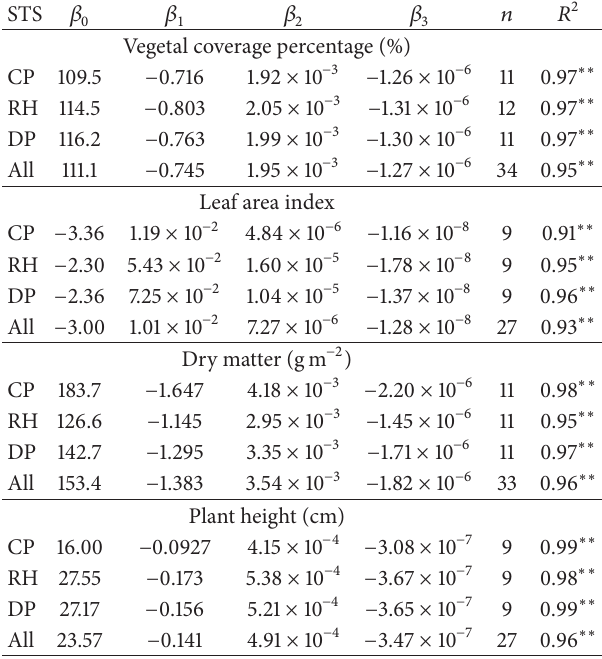
Table3:Polynomialequations( 𝑌 = 𝛽 0 +𝛽 1 𝑋+𝛽 2 𝑋 2 +𝛽 3 𝑋 3 )relating the bean crop growth parameters to thermal time (degree-days accumulated), for each soil tillage system (STS): chisel ploughing (CP),diskploughing(DP),andrevolvinghoe(RH),andconsidering all STS as a single data set (All), in Campinas city, S˜ao Paulo